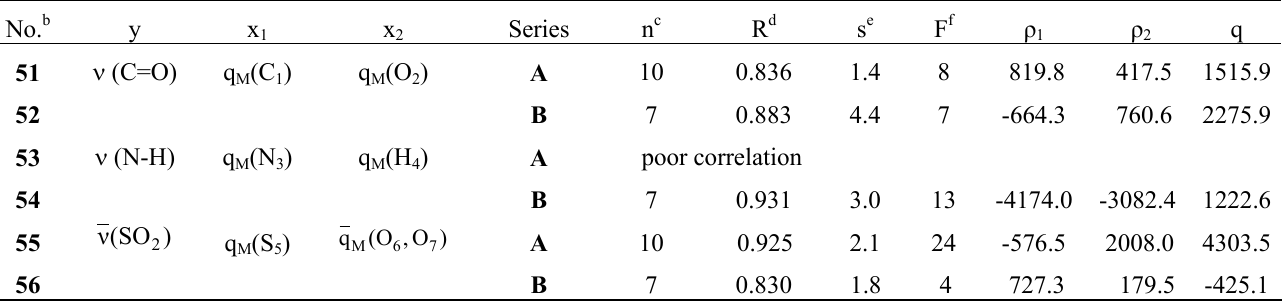
Table 6. Dual parameter correlations of IR spectral data a , and theoretical parameters for the